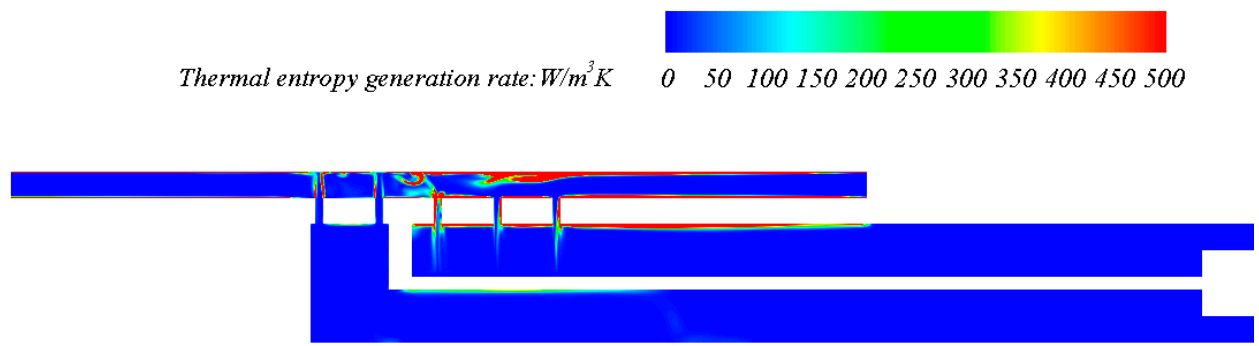
Figure 15. Thermal entropy generation rate in the fluid domain ( x = 28.5 mm, DSJ off).